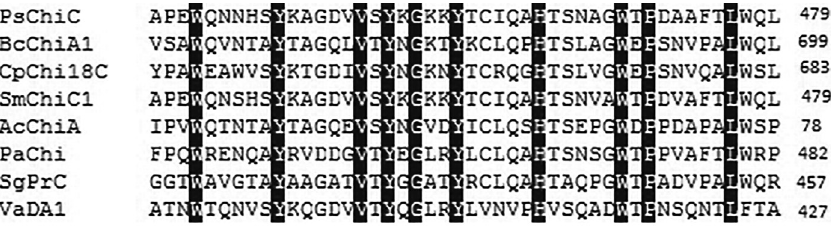
Figure 3 - Amino acid sequence alignment of the chitin-binding domains of PsChiC with those of other bacterial enzymes (protease, deacetylase and chitinases). PsChiC - Pseudomonas sp. TXG6-1 chitinase C (this study), BcChiA1 - Bacillus circulans chitinase A1 (AAA81528), CpChi18C - Clostridium paraputrificum chitinase 18C (BAD29950), SmChiC1 - Serratia marcescens GEI chitinase C1 (ACX42073), AcChiA - Acidobacterium capsulatum ATCC51196chitinaseA(ACO33699),PaChi- Paeruginosa UCBPP-PA14chitinase(ABJ11480),SgPrC- Streptomycesgriseus serinepro- tease (AAA26813), and VaDA1 - Vibrio alginolyticus deacetylase DA1 (CAC29092). Black shading indicates identical amino acid